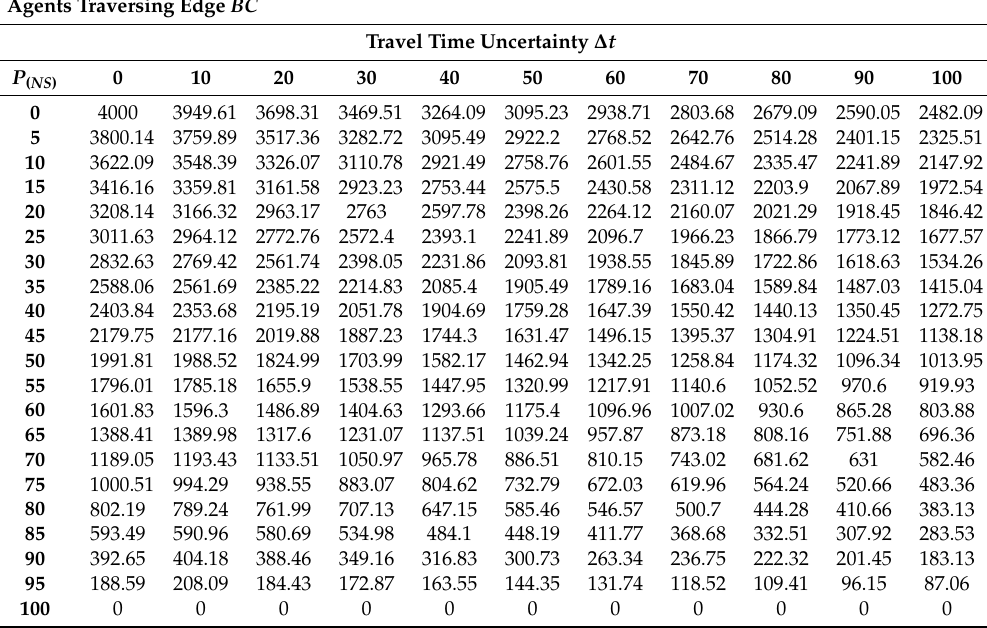
Table A3. Average number of agents traversing edge BC for given values of ∆ t and P ( NS ) . Agents Traversing Edge BC Travel Time Uncertainty ∆